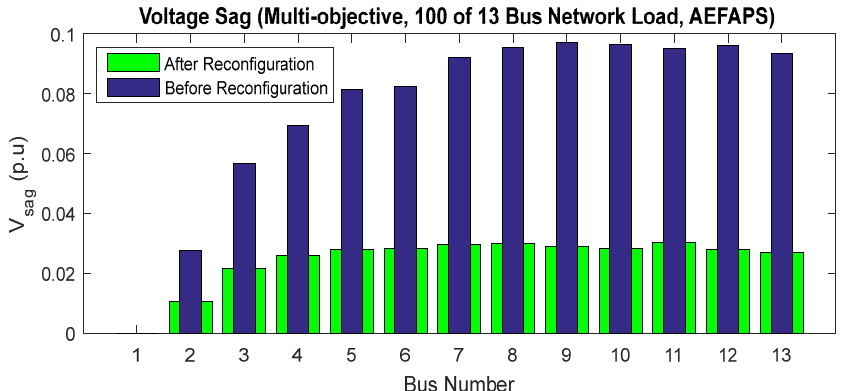
Figure 18. Voltage sag before and after many-criteria reconfiguration of an unbalanced 13-bus network using AEFAPS.